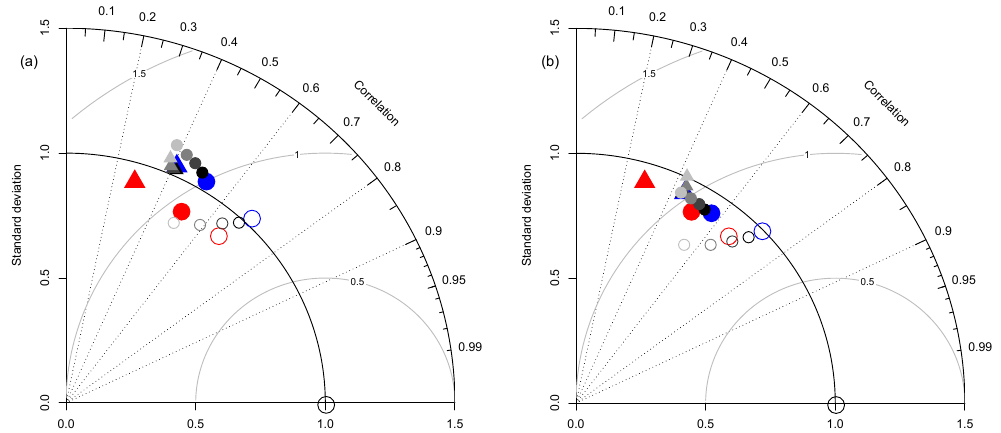
Figure 10. Normalized Taylor diagrams on the CRU CL-v2 annual mean precipitation rate for the standard CTRL experiment (red) and a series of DOWN experiments (grey and blue). The circles depict the score when all grid points are considered, whilst the triangles stand for points with an elevation greater than 800m. The filled symbols correspond to the Taylor Diagram computed on the high-resolution grid whilst the empty symbols are for the T21 grid. All the DOWN experiments presented here use z q = 2000m. The different shades of greys are for different α min q ranging from 0.75 (dark) to 0.9 (light), for f s = 1 . 0 (a) and f s = 0 . 6 (b) . DOWN with z q = 2000m, α min q = 0 . 7 and f s = 1 . 0 (a) and DOWN with z q = 2000m, α min q = 0 . 7 and f s = 0 . 6 (b) are in blue. In this figure, the metrics (standard deviation, correlation and root mean square error) are computed from the annual mean climatic variables. The standard deviation in the observations is used to normalize the standard deviations and the root mean square error.